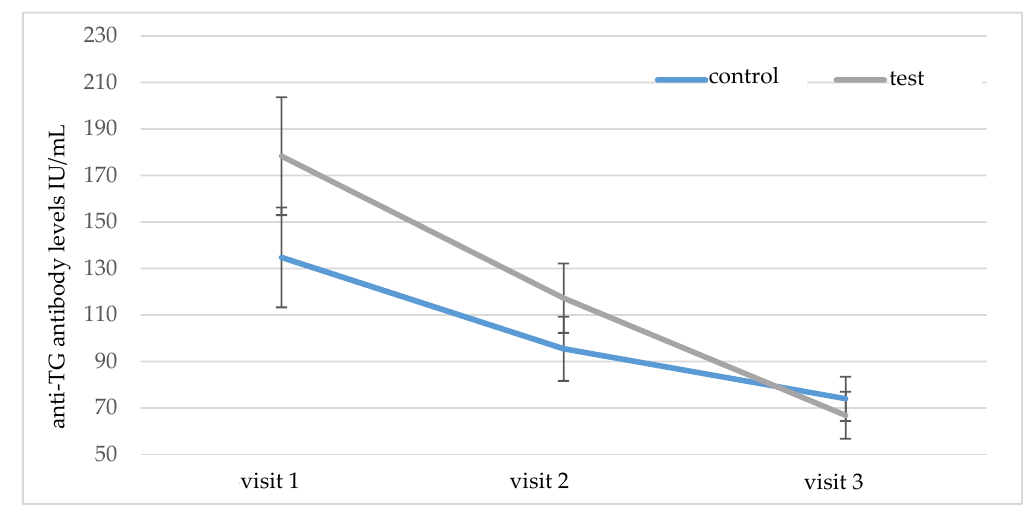
Figure 4. Comparison of test group A and control group B in terms of anti-TG antibody levels during the six-month nutritional intervention.